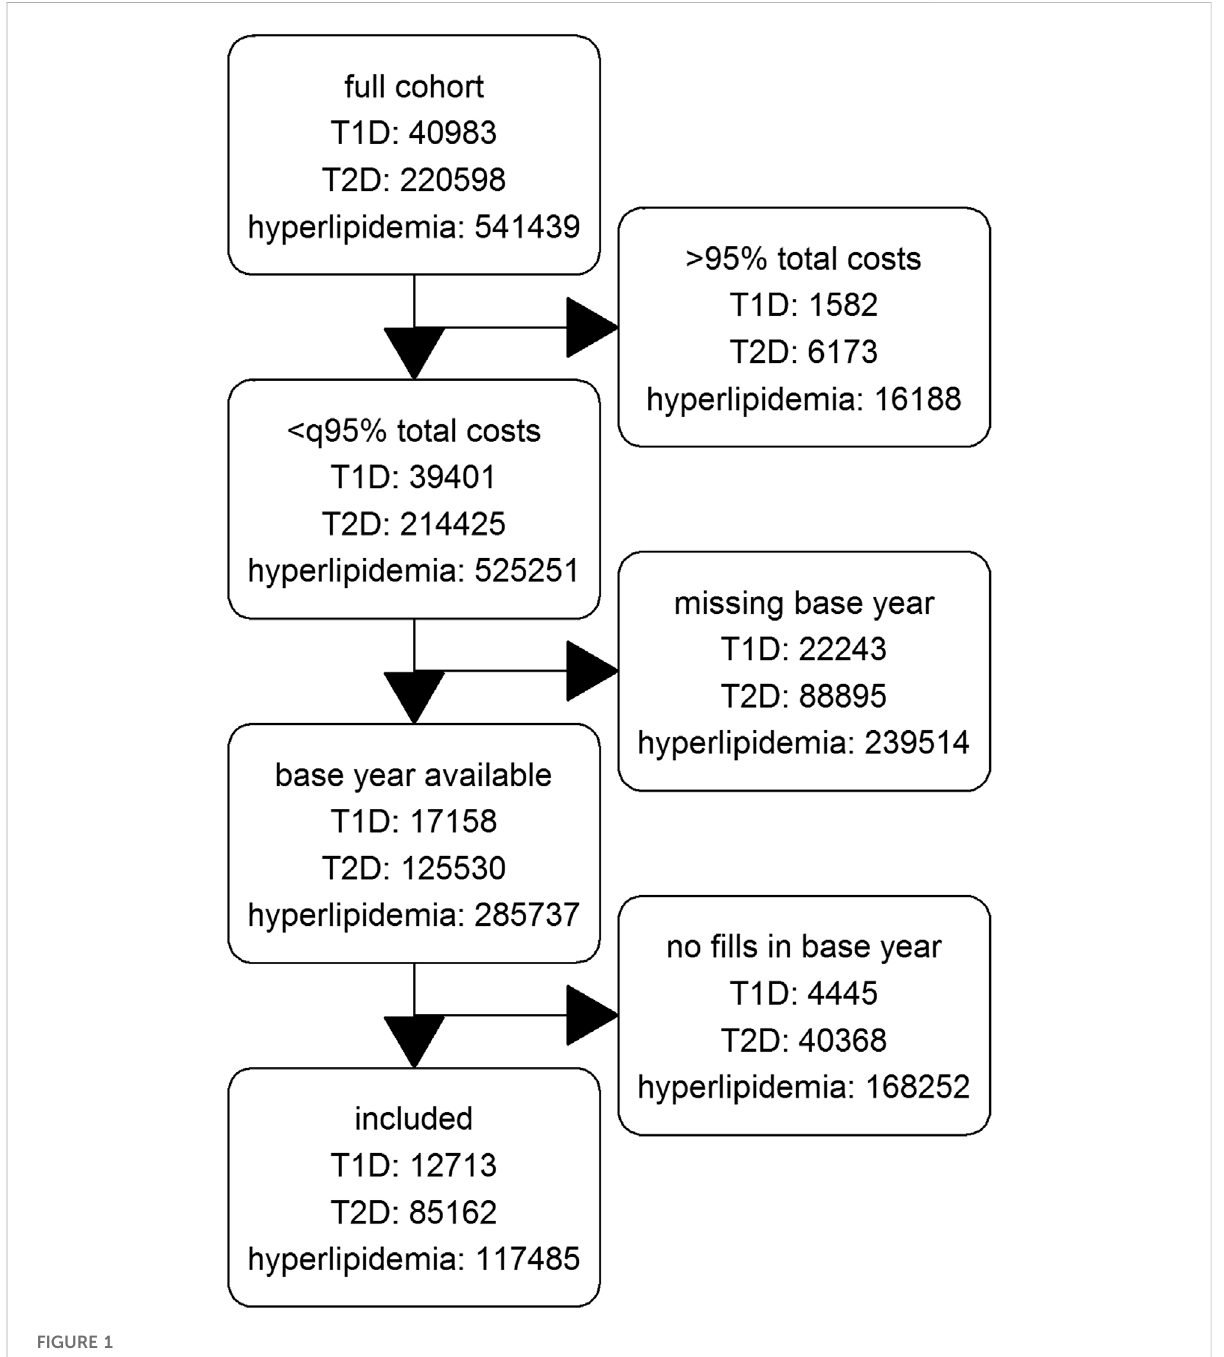
FIGURE 1 Flowchart of